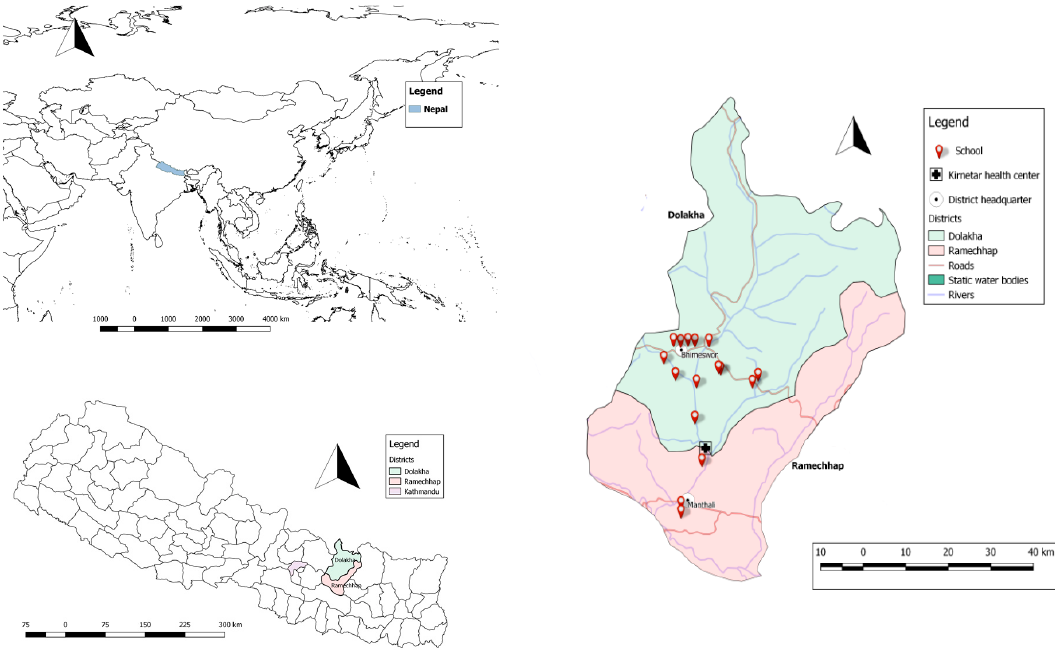
Figure 1. Top left : World map showing Nepal; Bottom left : Map of Nepal highlighting Dolakha and Ramechhap districts; Right : Map of Dolakha and Ramechhap districts showing the surveyed schools.